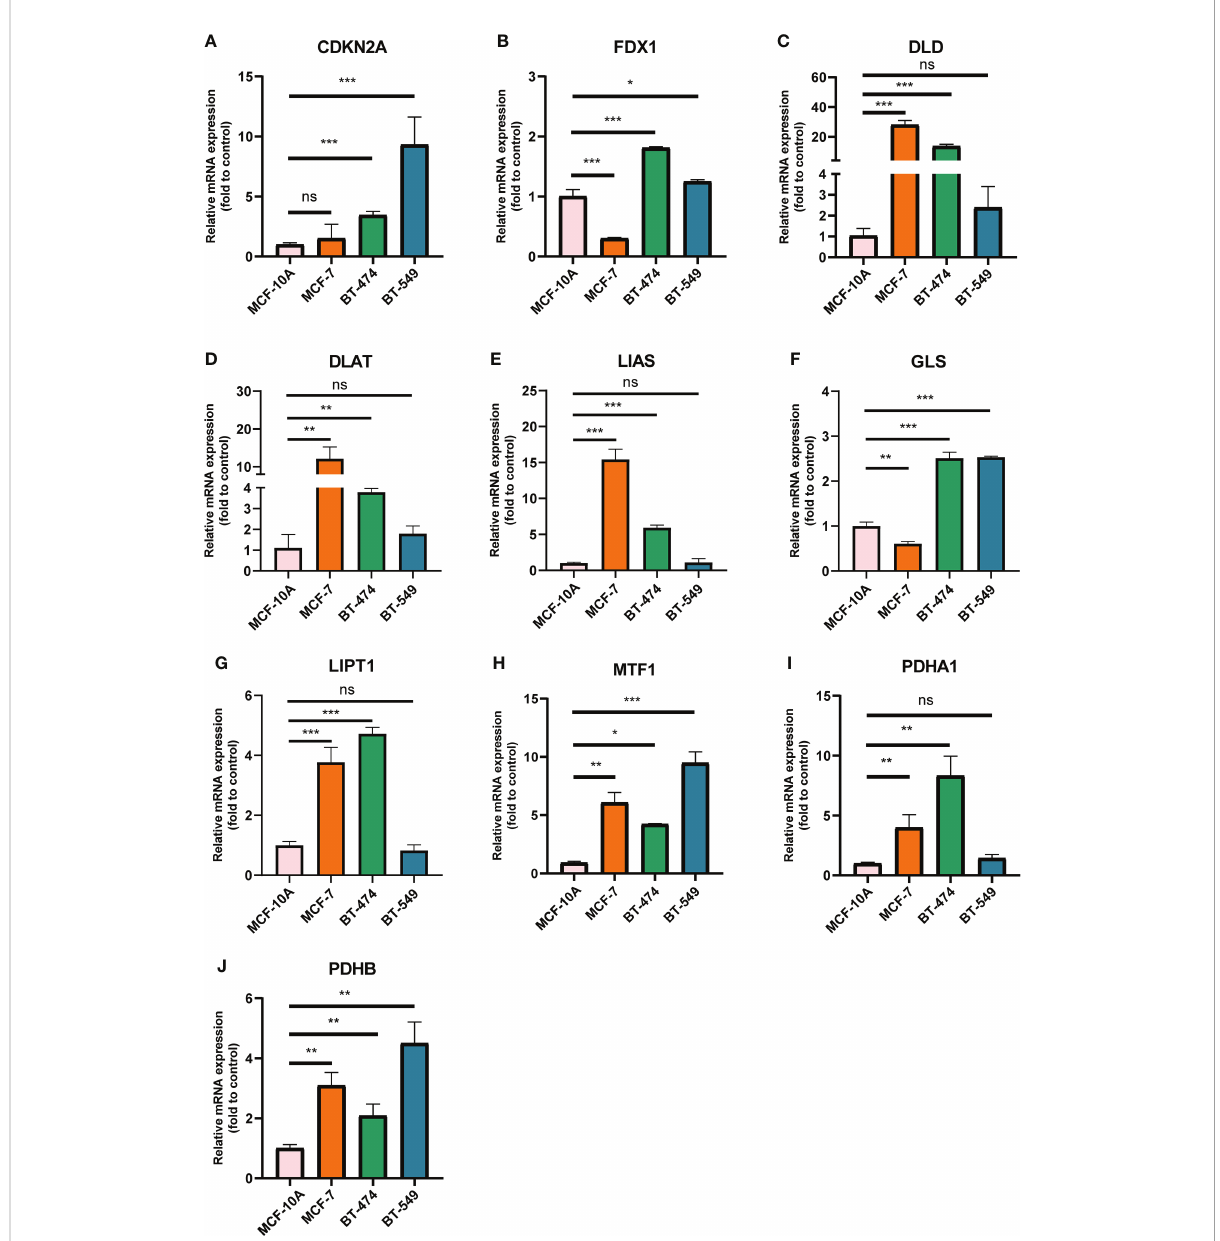
FIGURE 2 mRNA levels of CRGs in BC cell lines and human normal mammary epithelial cell quanti fi ed by real-time PCR. (A) CDKN2A; (B) FDX1; (C) DLD; (D) DLAT; (E) LIAS; (F) GLS; (G) LIPT1; (H) MTF1; (I) PDHA1; (J) PDHB. The experiments were repeated three times. *p < 0.05, **p < 0.01, ***p < 0.001; ns, no statistically signi fi